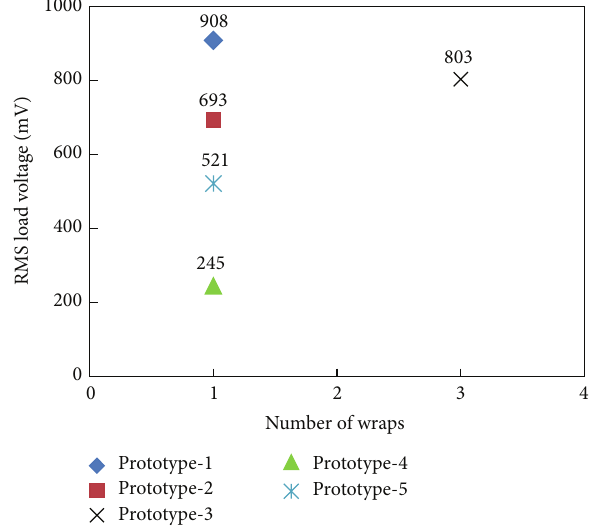
Figure 19: Induced voltage in inductive energy harvesters as a function of number of core’s wraps at 155 A current level.